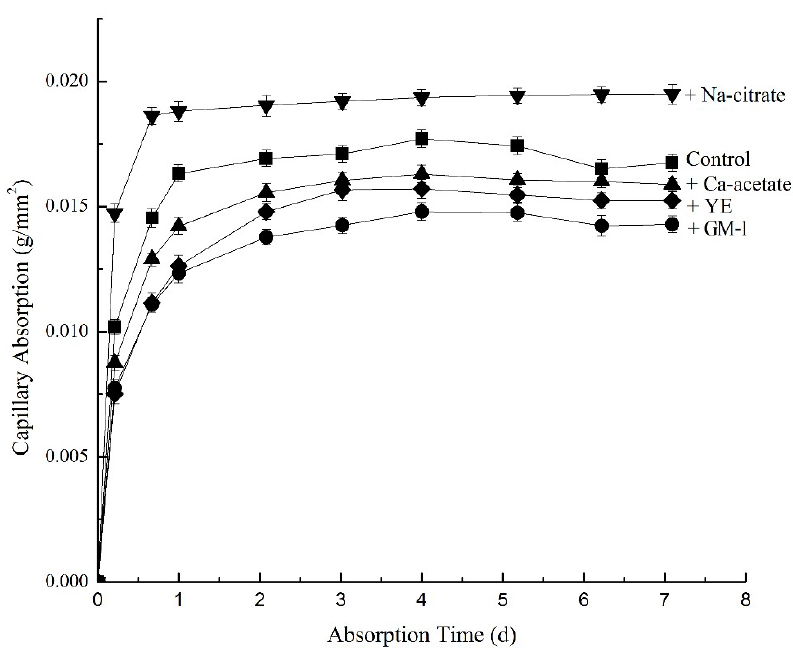
Figure 3. Capillary absorption of mortars.